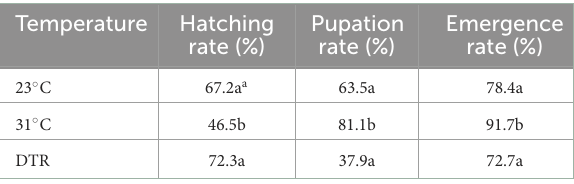
TABLE 1 Effects of temperature on mosquitoes’ life